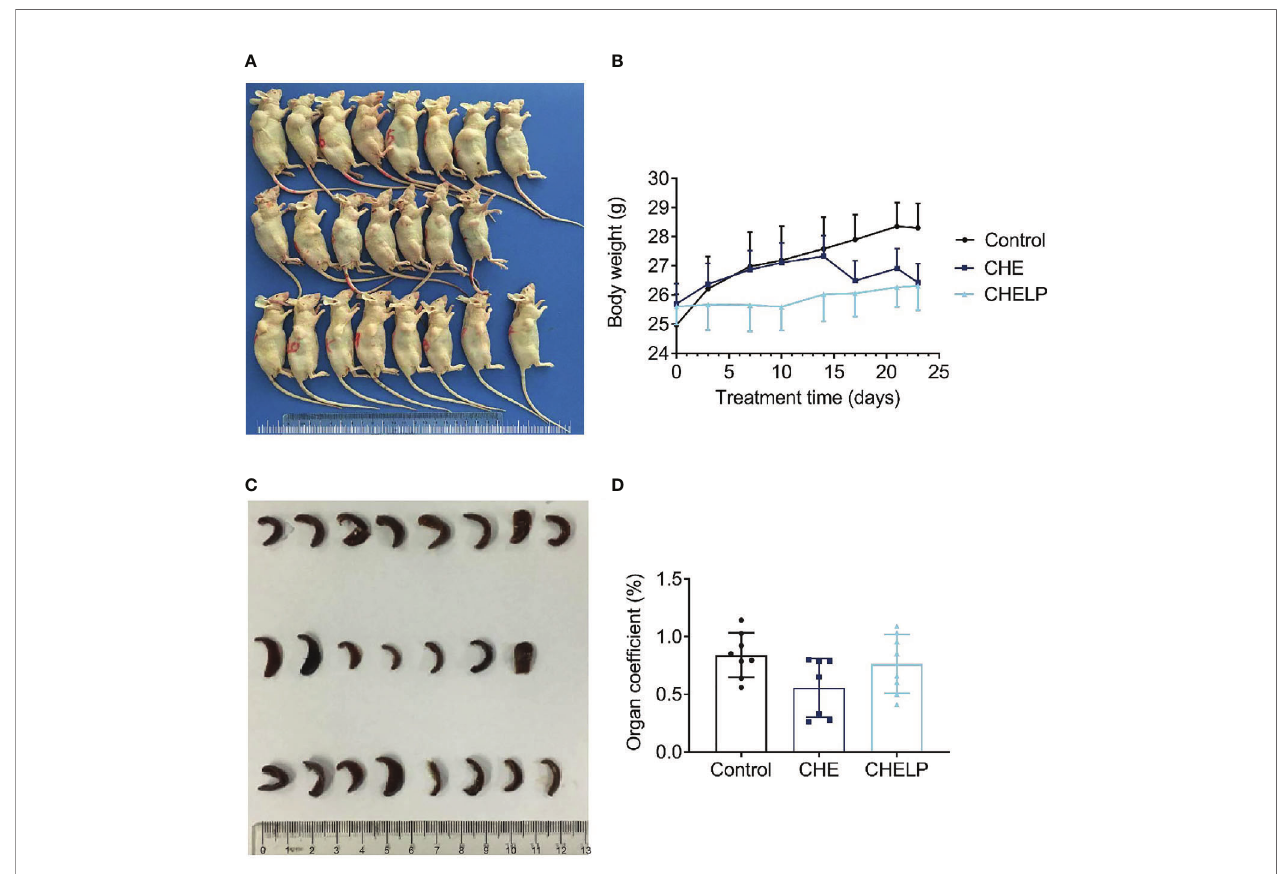
FIGURE 11 | Safety evaluation. (A) The picture of nude mice in different groups after sacri fi ced. (B) Body weight; (C) spleen morphology; (D) organ coef fi cient of spleen. (Saline group n = 8; CHE treatment group n = 7; CHELP treatment group n =